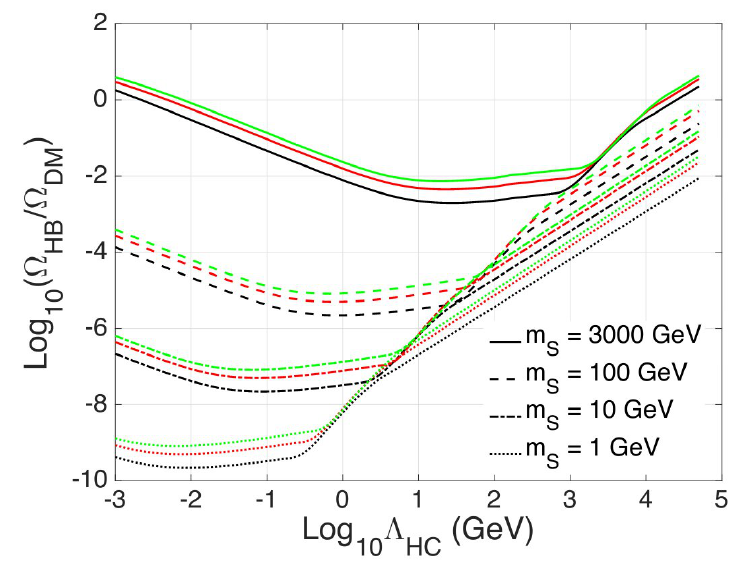
Figure 22: Relic density of dark “hyperbaryons” versus the “hypercolor” confining scale, for a series of constituent quark masses m (blue, red and green curves, respectively), from Ref. [ 127 ]